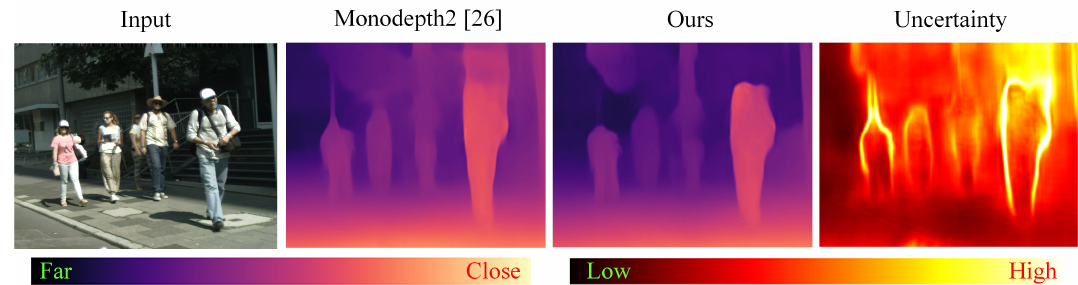
Figure 1. Depth map with edge-aware. The previous method (monodepth2) is prone to blurring on object boundaries. In contrast, our proposed method can predict smoother, sharper, and high-quality depth maps by considering the depth uncertainty.